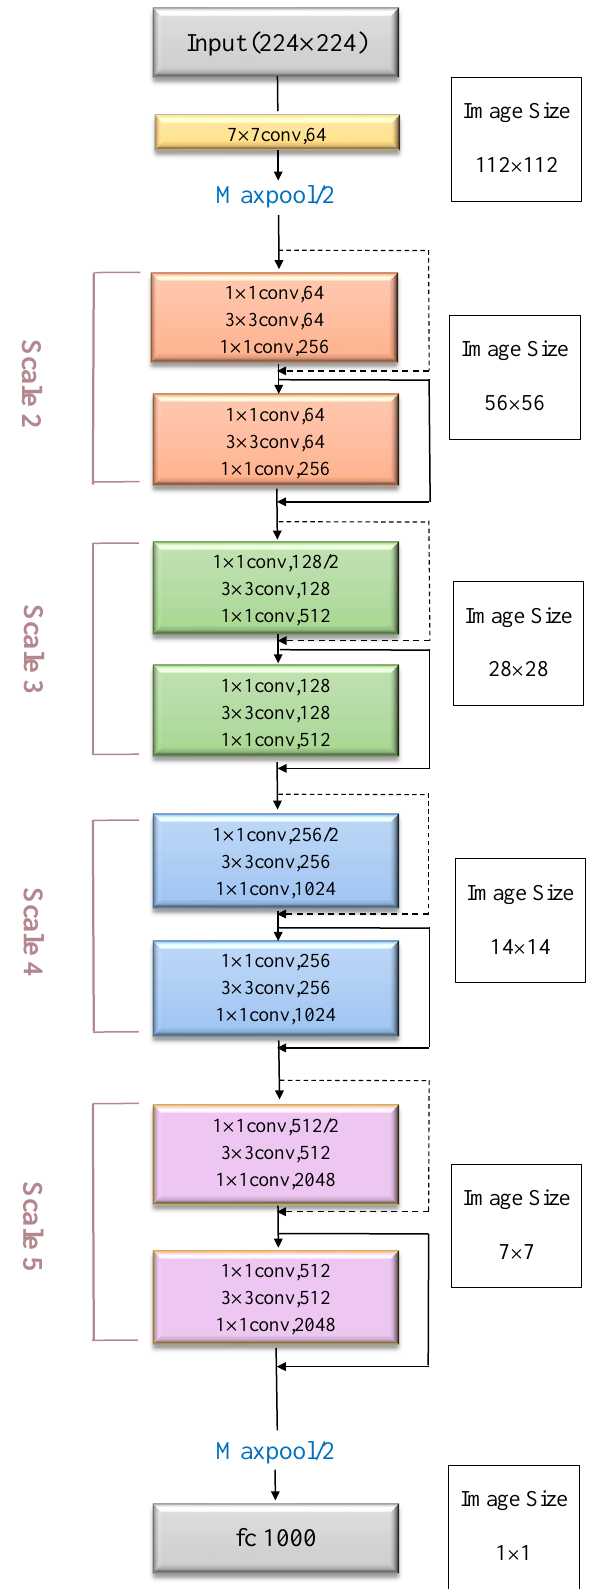
Figure 10. Resnet50 model for the detection of strawberry